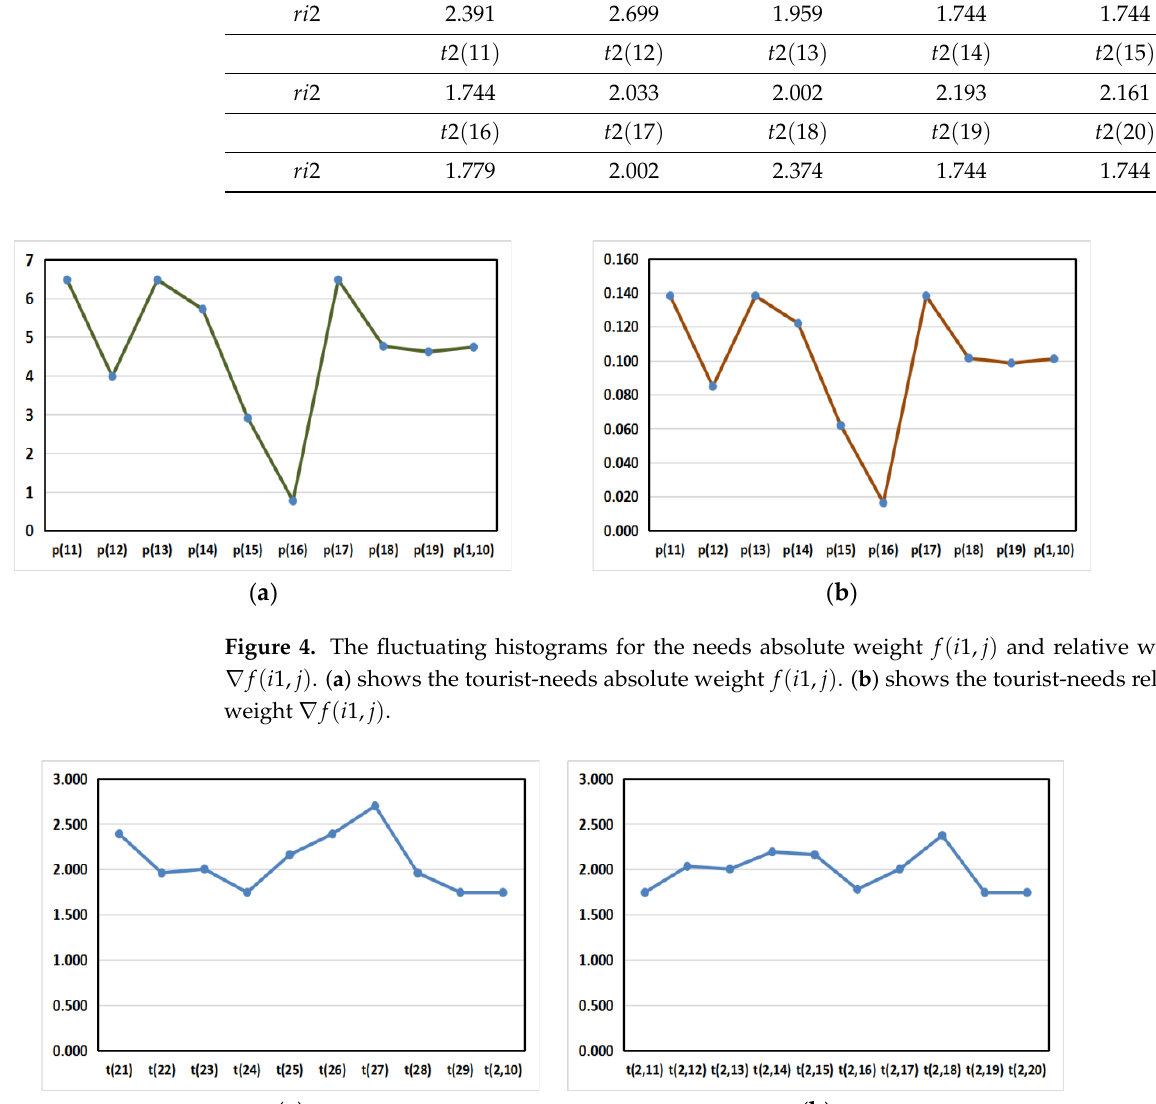
Figure 5. The recommendation function value for each water scenic spot. ( a ) shows the function values for the water scenic spots t 2 ( 1 ) ~ t 2 ( 10 ) . ( b ) shows the function values for the water scenic spots t 2 ( 11 ) ~ t 2 ( 20 ) .